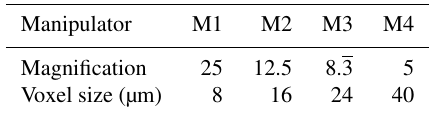
Table 2. Manipulator settings with magnification and voxel